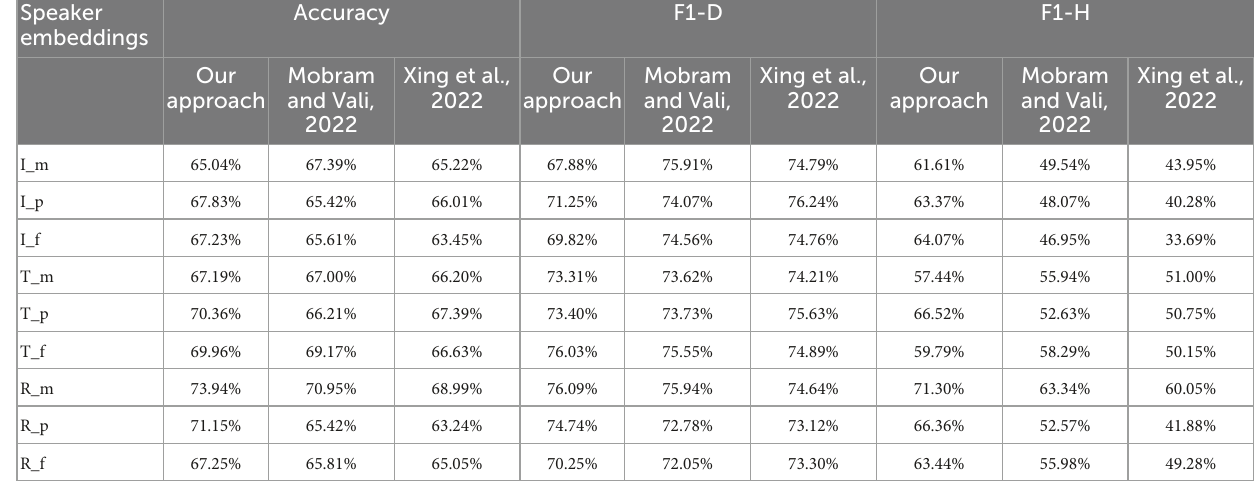
TABLE 7 Performance comparison of three methods with speaker embeddings combined with nine tasks. Speaker embeddings